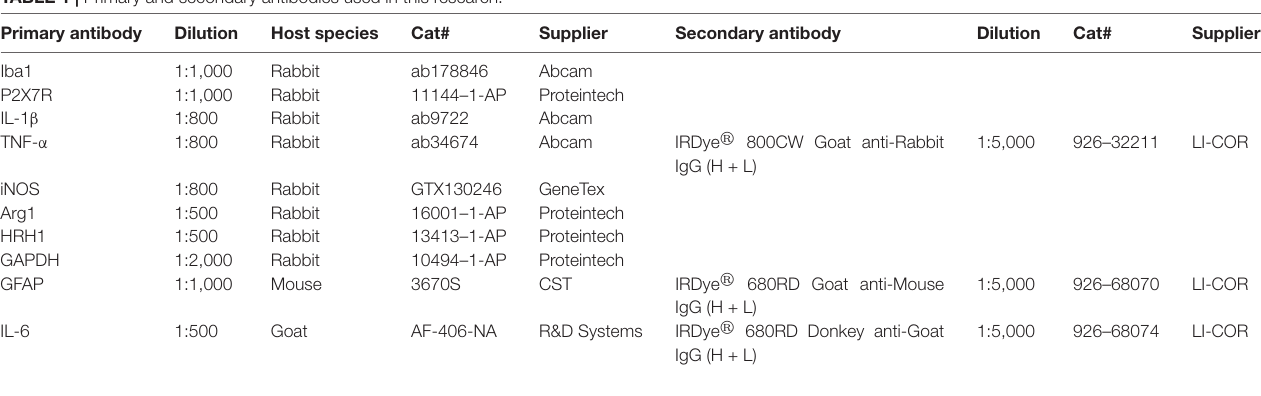
TABLE 1 | Primary and secondary antibodies used in this research. Primary antibody